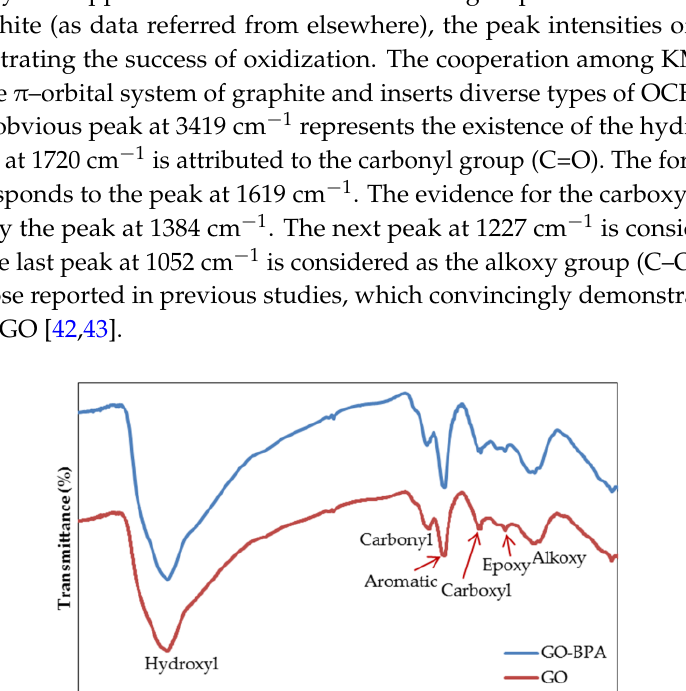
Figure 10. Schematic representation of π–π interactions and hydrogen bonding between BPA and GO.